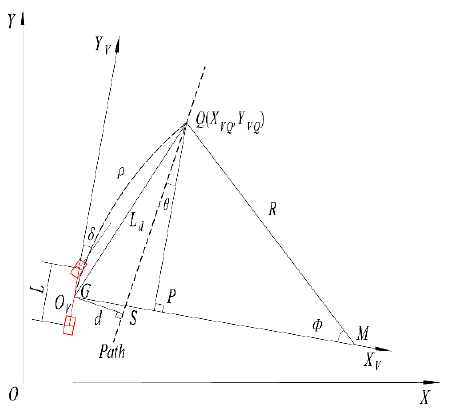
Figure 3. The pure pursuit model of the transplanter.